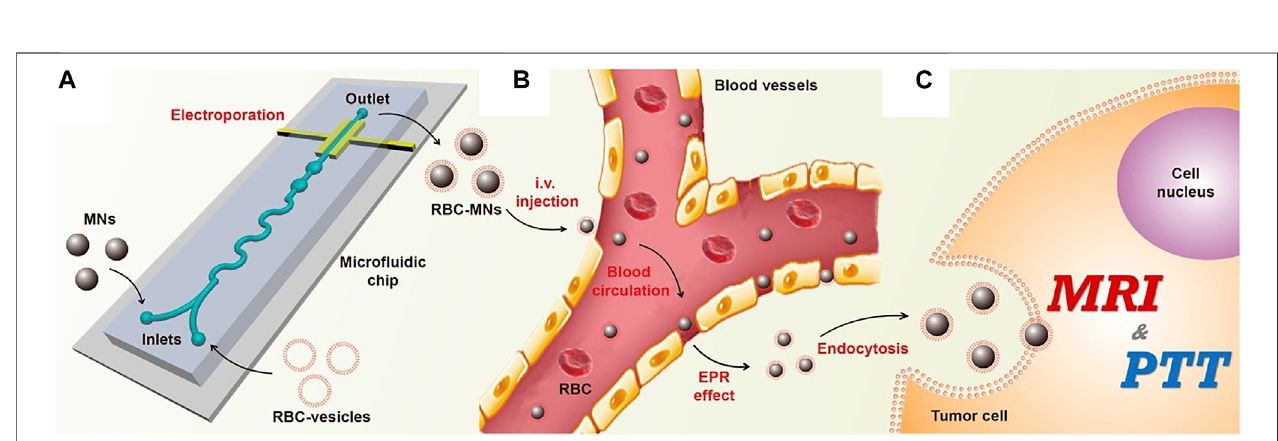
FIGURE 4 | Schematic of micro fl uidic electroporation-facilitated synthesis of RBC-membrane capped magnetic nanoparticles. (A) Micro fl uidic electroporation facilitates the synthesis of RBC-MNs. (B) Subsequently, the RBC-MNs, which are collected from the micro fl uidic chip, accumulate at the tumor site after the blood circulation. (C) Biomimetic RBC-MNs are further used for enhanced in vivo tumor MRI and PTT. Adapted from Rao et al. (2017). Copyright @ 2017 (American Chemical Society).